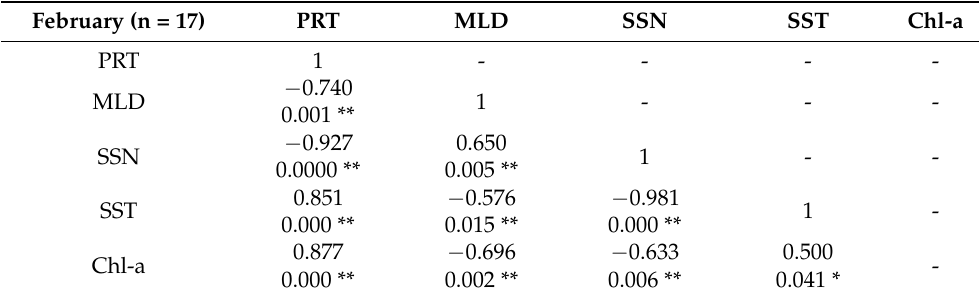
Figure 9. The seasonal distribution between 3 years average of protein concentration 2003–2005 period and 2017–2019 period, which were the oldest and latest data accessible from the MODIS- Aqua satellite. Table 3. The correlation between the protein concentration of phytoplankton with satellite-derived data of physical, chemical, and biological variables during